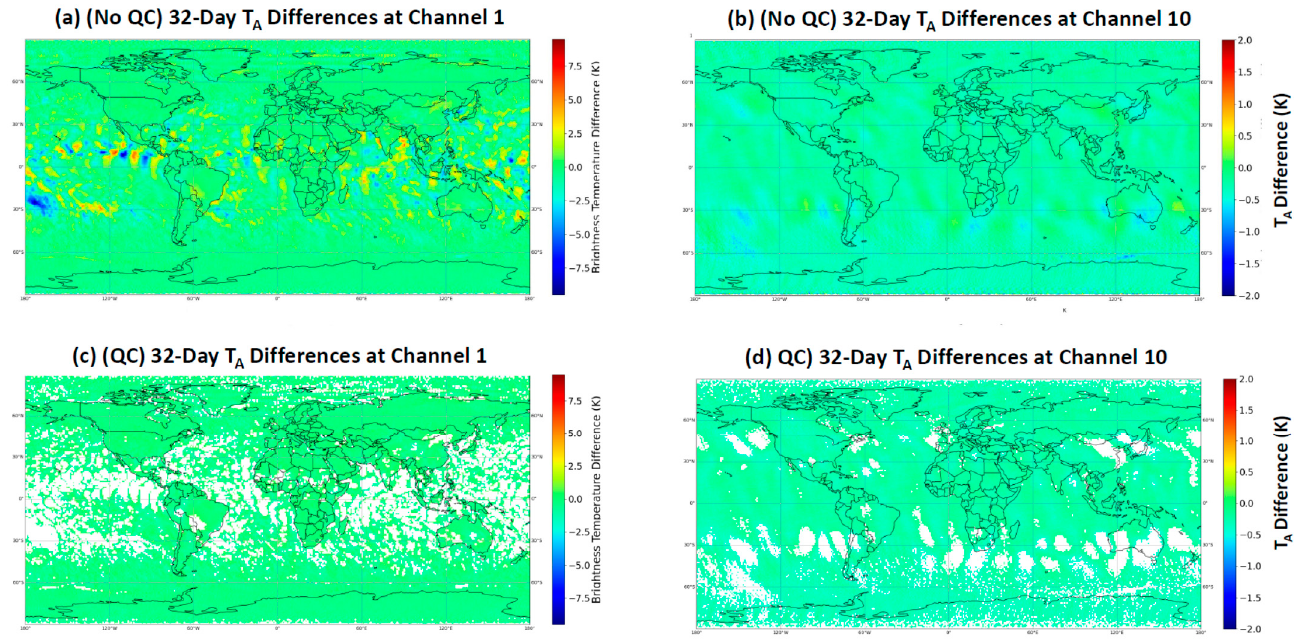
Figure 7. Global distribution of ∆ O N 20 − SNPP 32 D , Point (𝑖, 𝑗) at channels 1 and 10 for the SNPP and NOAA-20 ATMS TDR (antenna temperature or T A ) data with and without the QC scheme applied. The ATMS data are gridded at 1 ◦ × 1 ◦ resolution covering the period from 1 November 2020, to 2 December 2020. ( a ) Channel 1 without the QC. ( b ) Channel 10 without the QC. ( c ) Channel 1 with the QC. ( d ) Channel 10 with the QC.